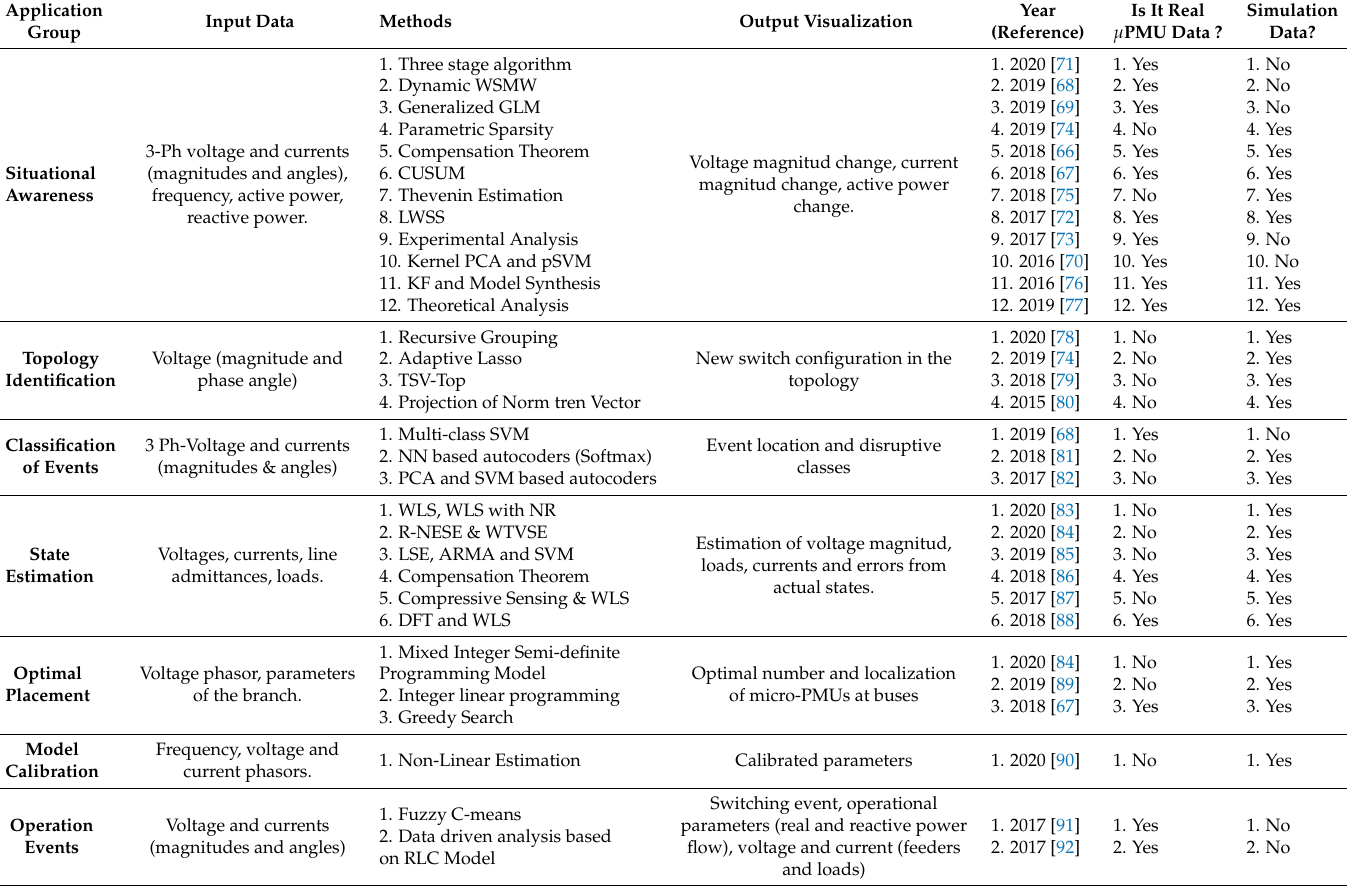
Table 2. Recent application groups of µ PMU